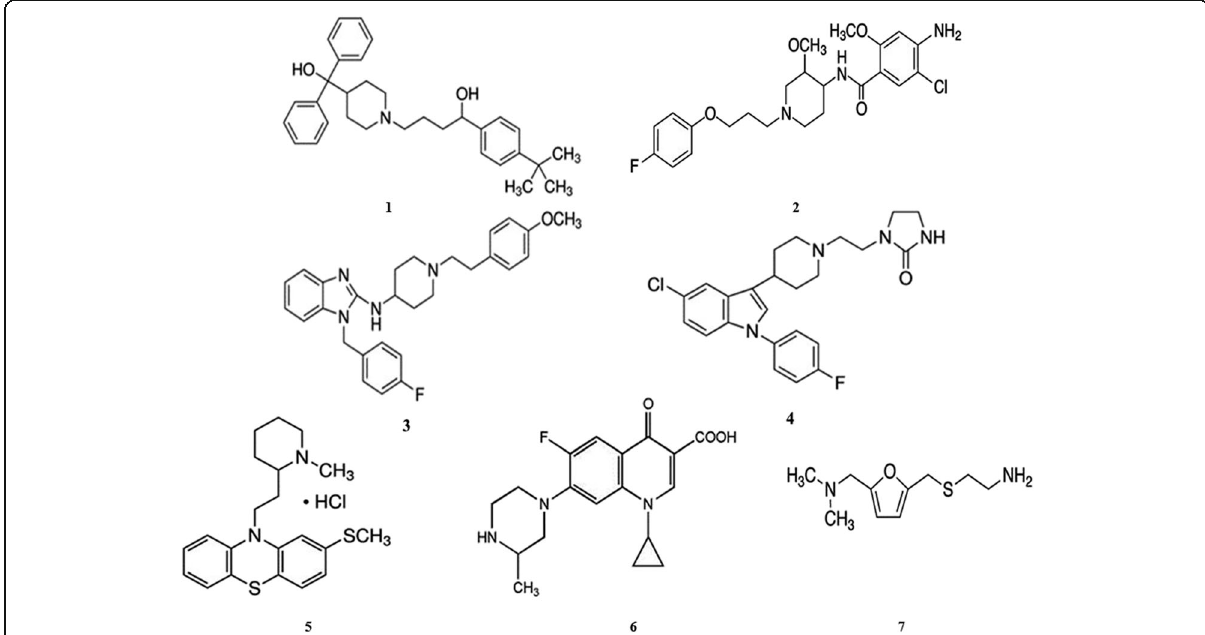
Fig. 1 Chemical structures of Terfenadine ( 1 ), Cisapride ( 2 ), Astemizole ( 3 ), Sertindole ( 4 ), Thioridazine ( 5 ), Grepafloxacin ( 6 ), and Ranitidine ( 7